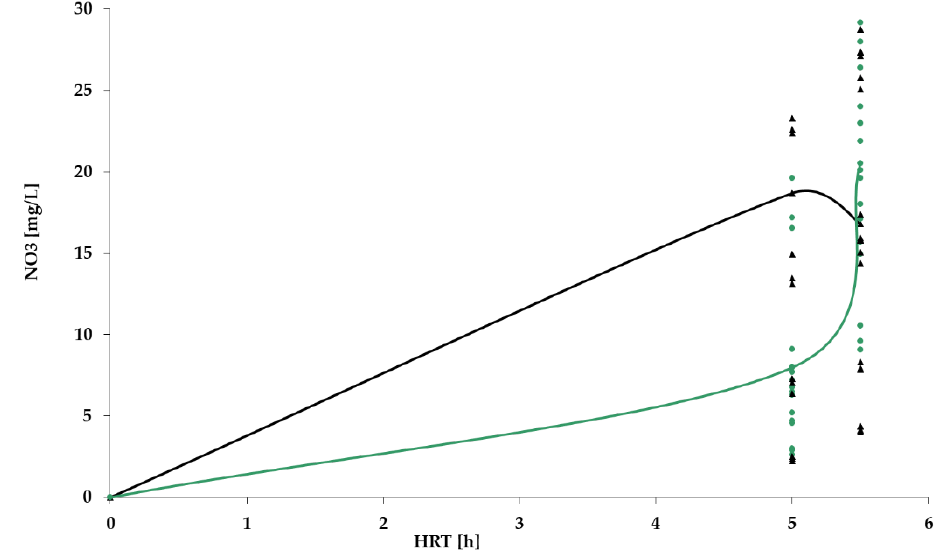
Figure 17. NO 3 dynamics for PV floating carrier: stage 1 (black); stage 2 (green).